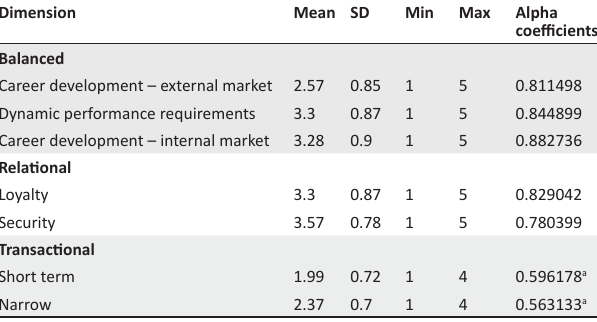
TABLE 3: Perceptions of employer’s obligations.